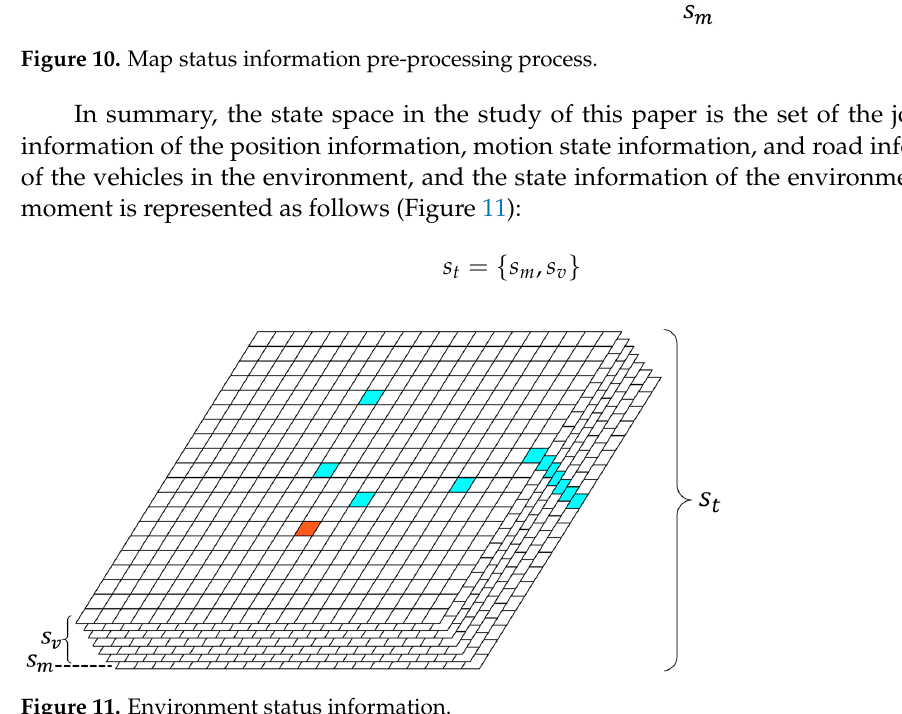
Figure 11. Environment status information.